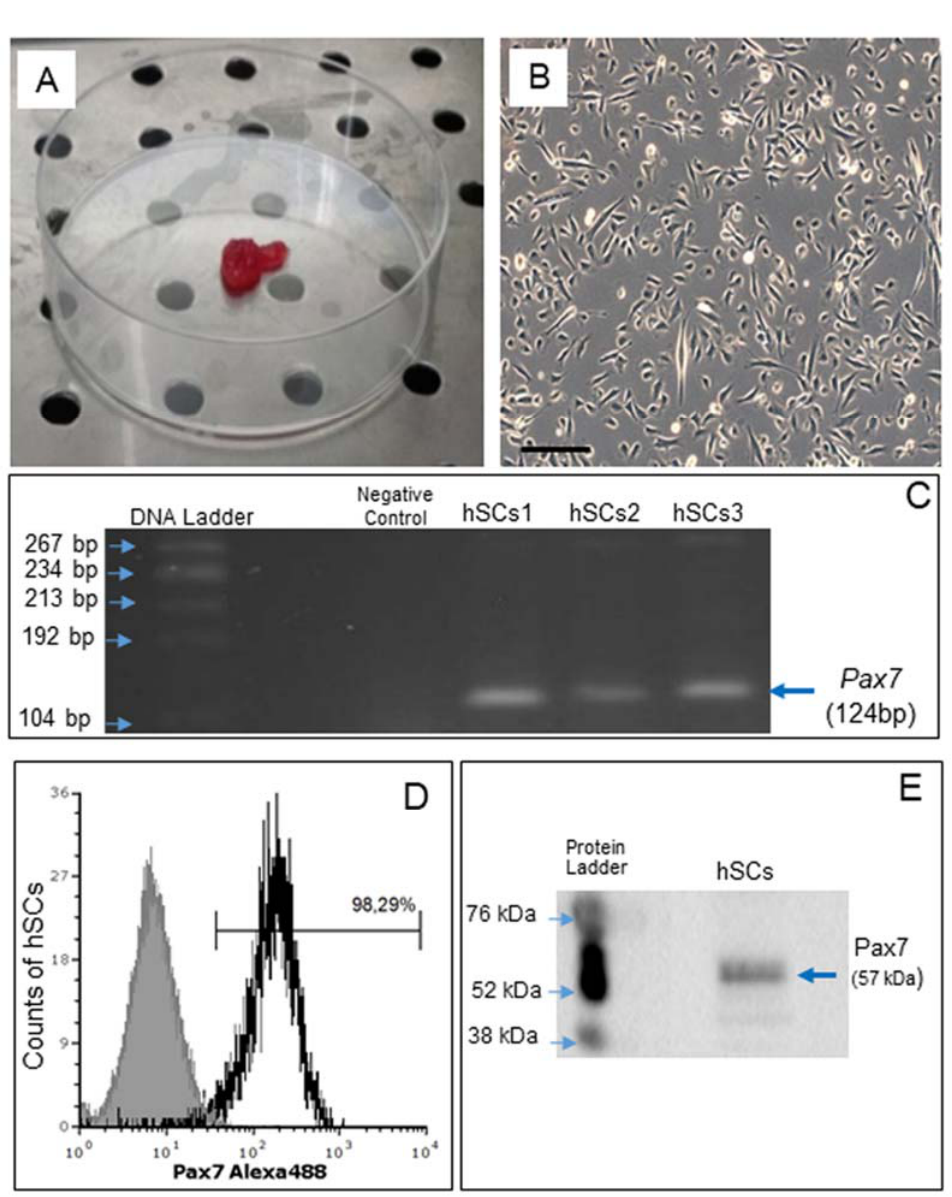
Figure 1. Human skeletal muscle biopsy ( A ) and primary cell culture of hSCs visualized by phase contrast microscopy, original magnification: 10×, scale bar 200 µm ( B ). RT-PCR analysis of Pax7 gene expression in hSC lines (hSCs1, hSCs2, hSCs3), passage 1. Negative control: PCR without cDNA template ( C ). Representative flow cytometry analysis of Pax7 protein expression in hSC lines, area in black boundaries represents the hSCs stained with primary anti-Pax7 antibody whereas the area under gray shading represents the hSCs only stained with secondary antibody ( D ). Representative Western blot analysis of Pax7, confirming the presence of Pax7 protein in hSCs ( E ).